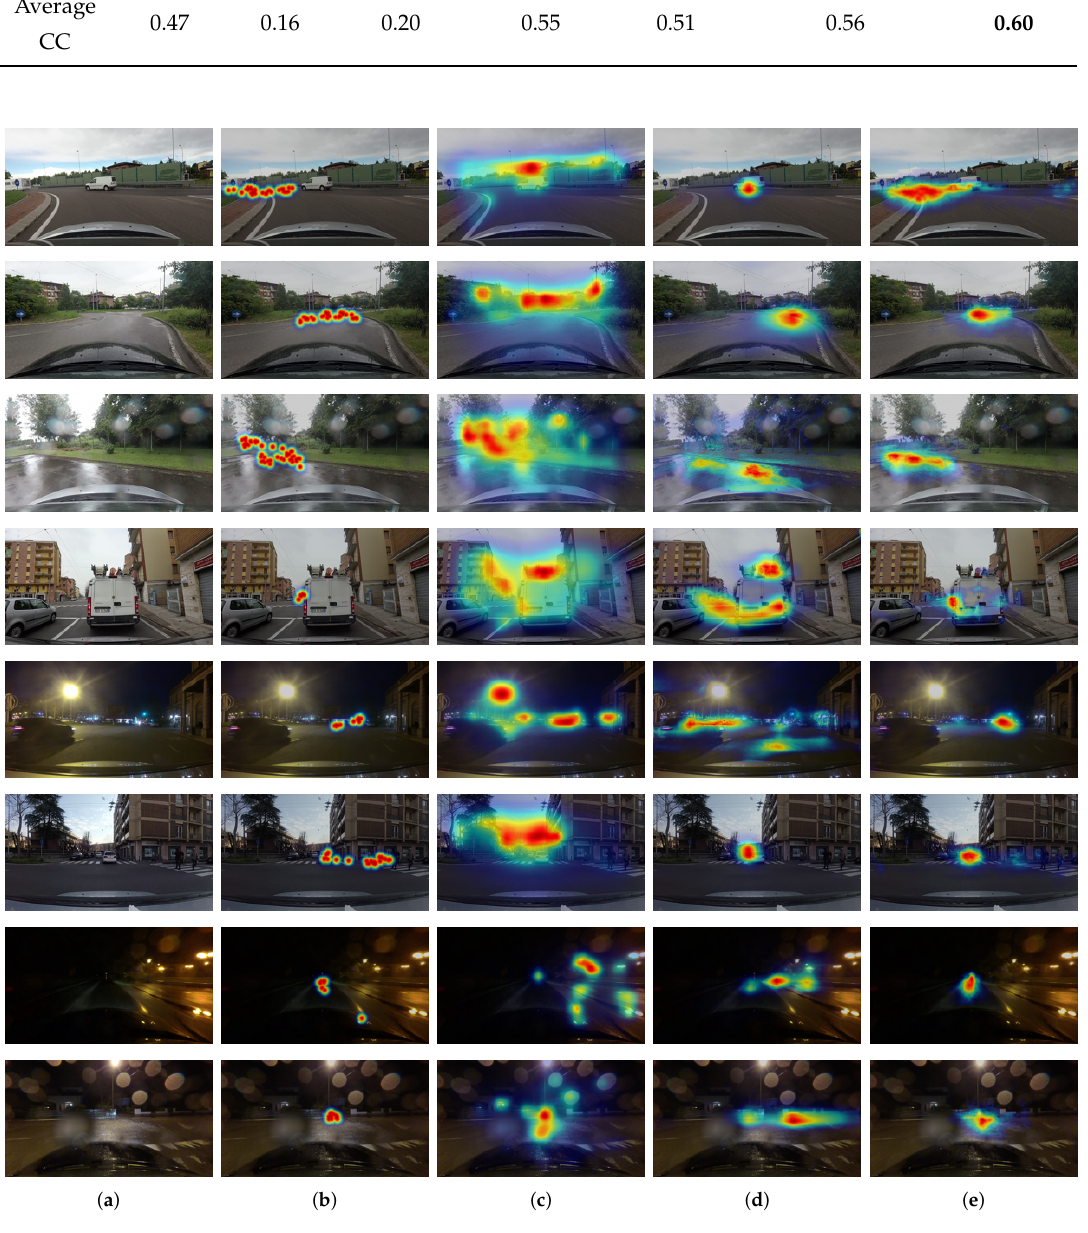
Figure 5. Visual comparisons of the predicted attention maps. The output attention maps overlay with the input images and scale to RGB components. ( a ) Input Image. ( b ) Ground-truth attention map. ( c ) Attention map by GBVS [17]. ( d ) Attention map of state of the art [11]. ( e ) Attention map of the proposed model. The proposed model can detect contextual and pixel-wise labels consistently and